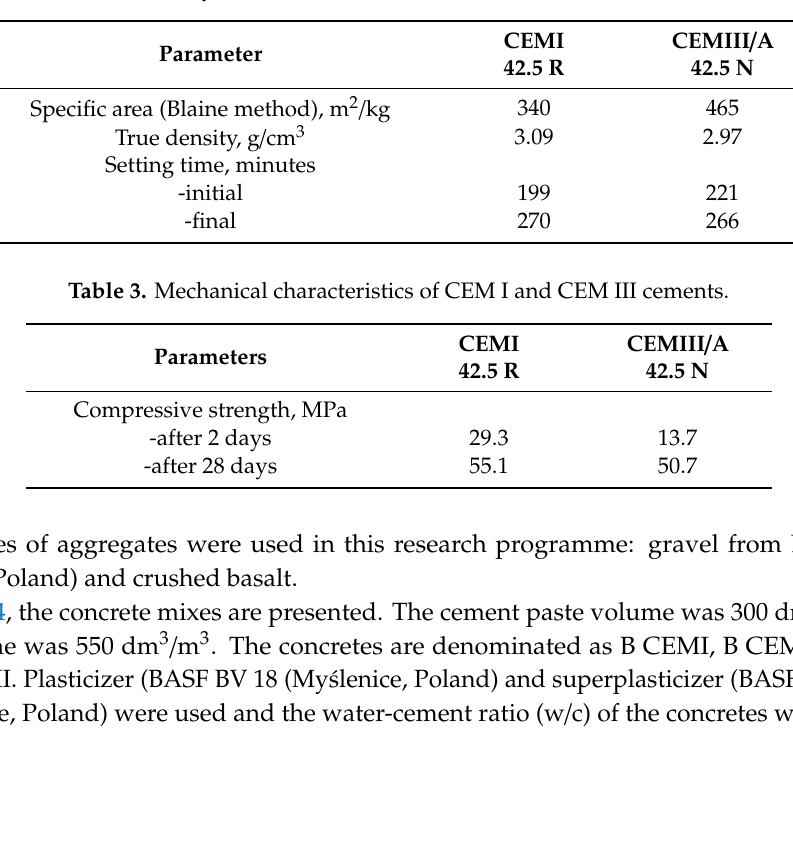
Table 2. Physical characteristics of CEMI and CEMIII cements.